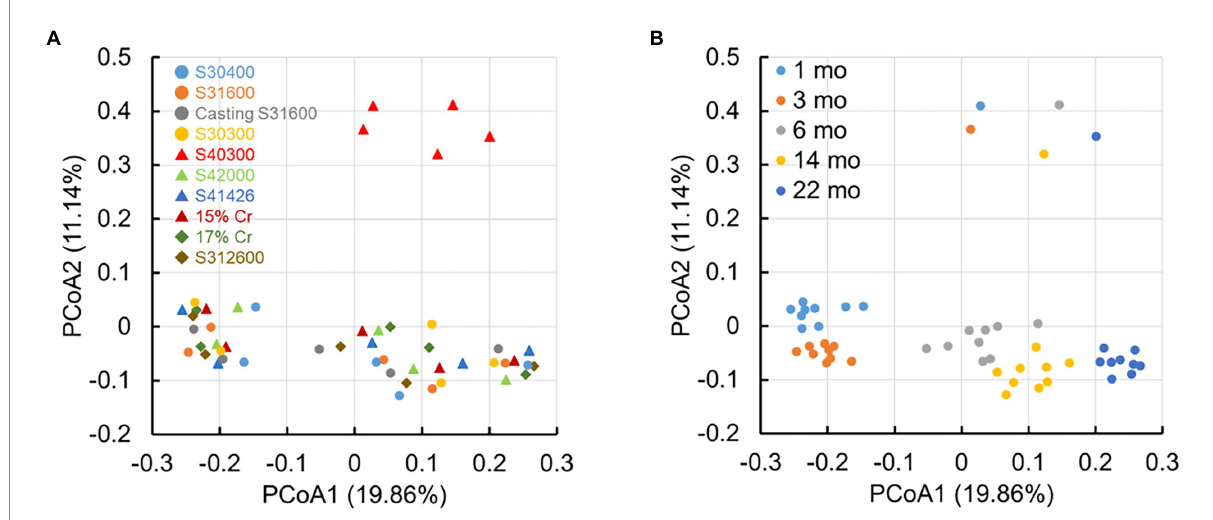
FIGURE 6 Principal coordinate analysis (PCoA) plots based on the unweighted UniFrac distances. S8, S30400; S6, S31600; S1, Casting S31600; S3, S30300; S4, S40300; L8, S42000; HP, S41426; 5C, 15% Cr; 7C, 17% Cr; and J, S31260.